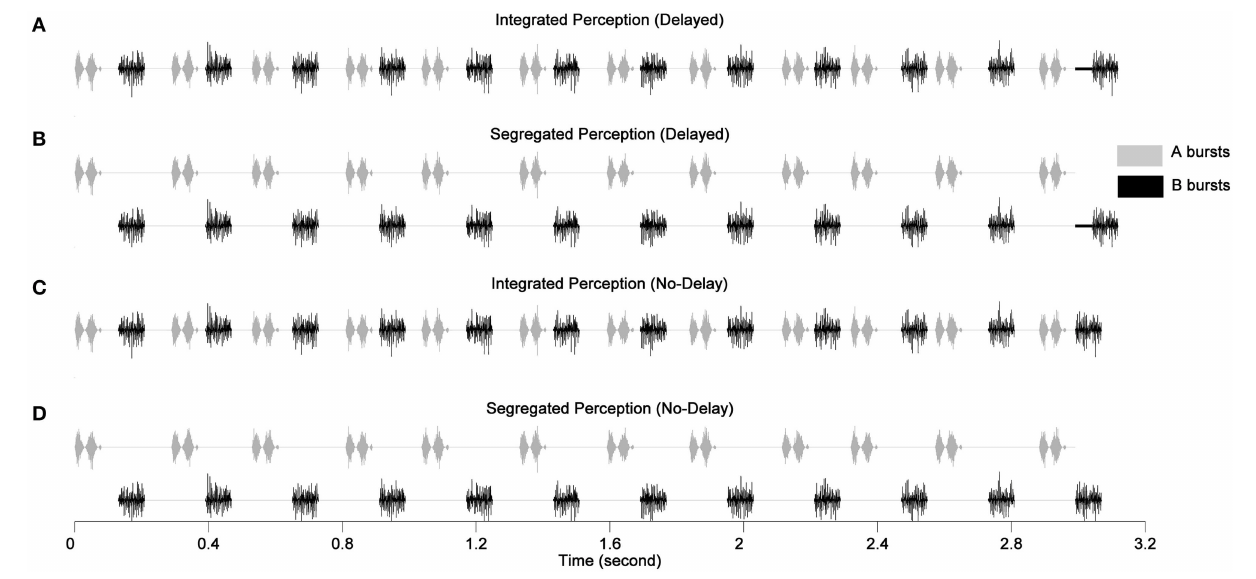
integrated perception and (B,D) depict the segregated perception. The spectral conditions for A and B bursts are A 678 and B 1234 , respectively. The AM rates shown on the A bursts and B bursts are 25 and 300Hz, respectively.